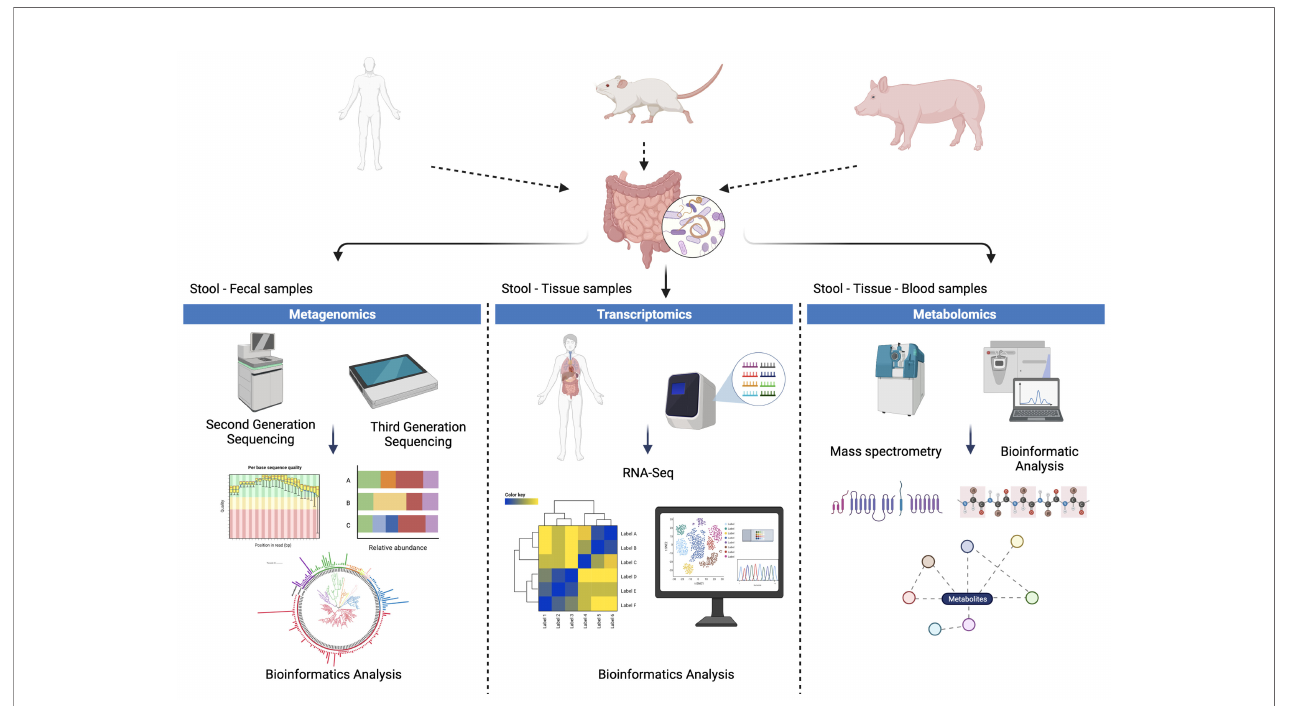
FIGURE 3 | Methodological approaches for the study of parasite-microbiota-host interactions. Studies in humans and in animal models, such as murine and porcine models, facilitate the evaluation of helminth-host microbiota interactions from different approaches such as: (i) metagenomic approaches by means of second and third generation sequencing, (ii) approaches based on transcriptomics and spatial transcriptomics and (iii) metabolomic approaches based on techniques such as mass